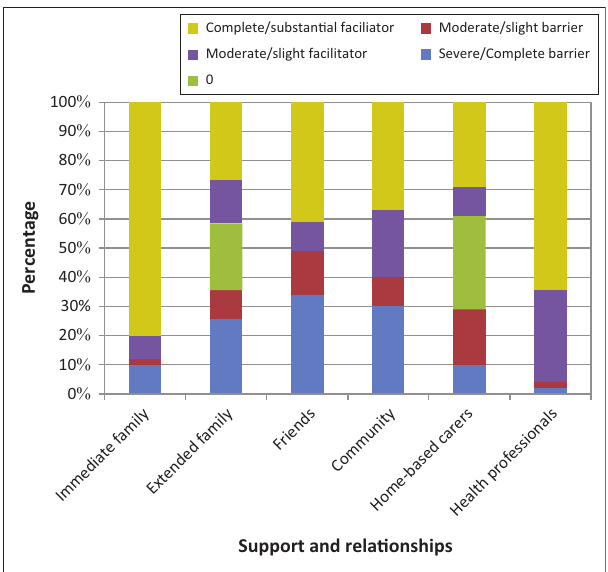
FIGURE 3: Support and relationships experienced as barriers and facilitators ( n =